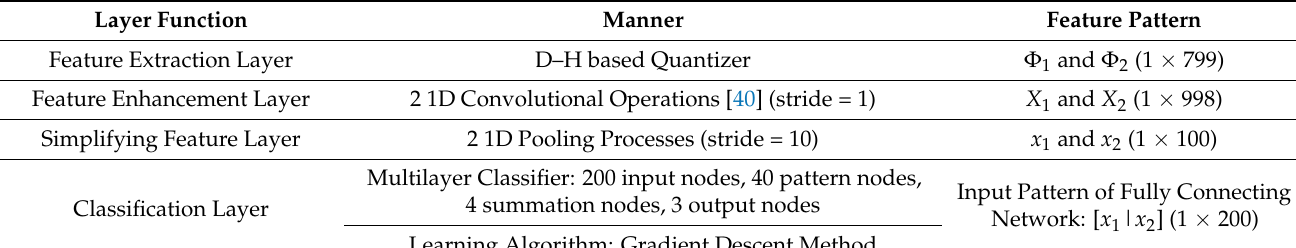
Table 2. Related data of 1D CNN-based multilayer classifier.